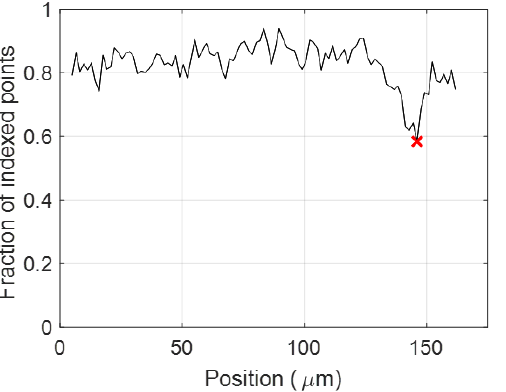
Figure 3. Interface location identified with a red cross using the location of the minimum of the fraction of unindexed points.